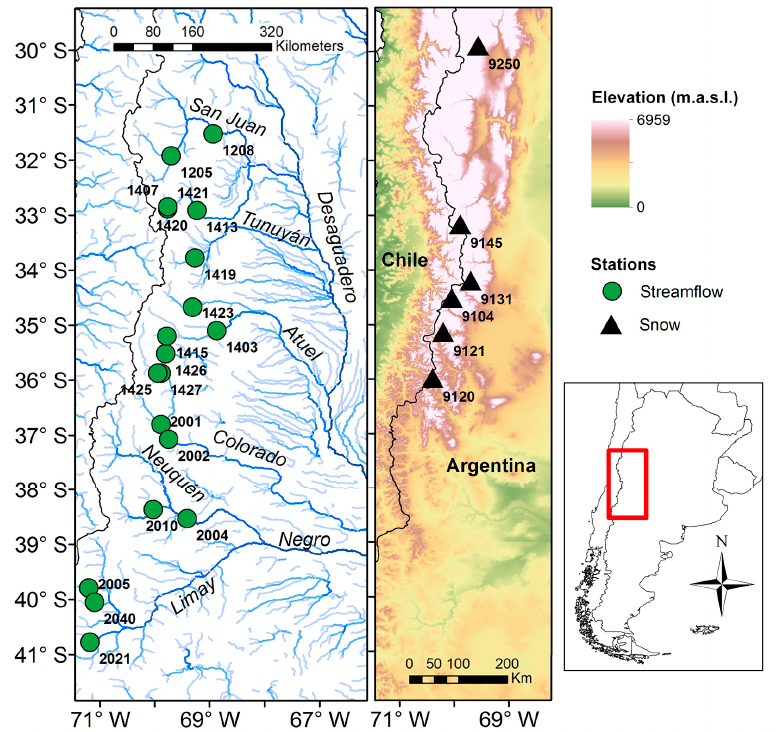
Figure 1. Spatial distribution of the hydrometeorological stations used in this study. The main rivers and the topography of the Central Andes in Argentina are also indicated.